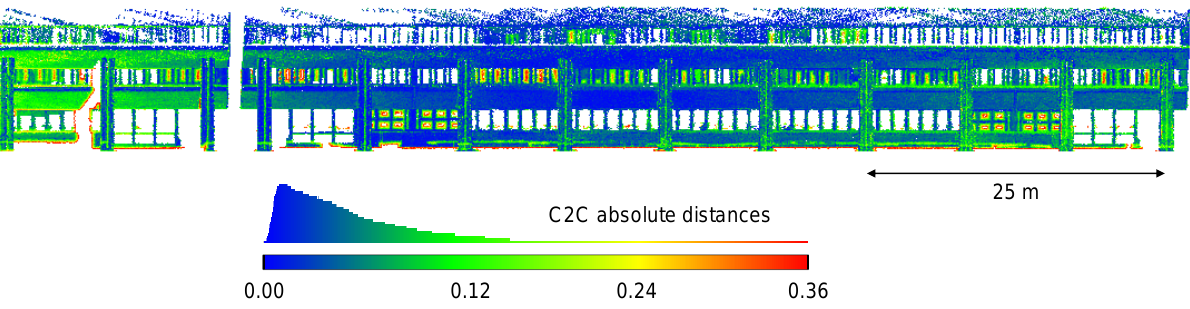
Figure 4. Cloud-to-cloud absolute distances for the left side of the south facade of the University building, computed between the HERON Lite model and the TLS point cloud.